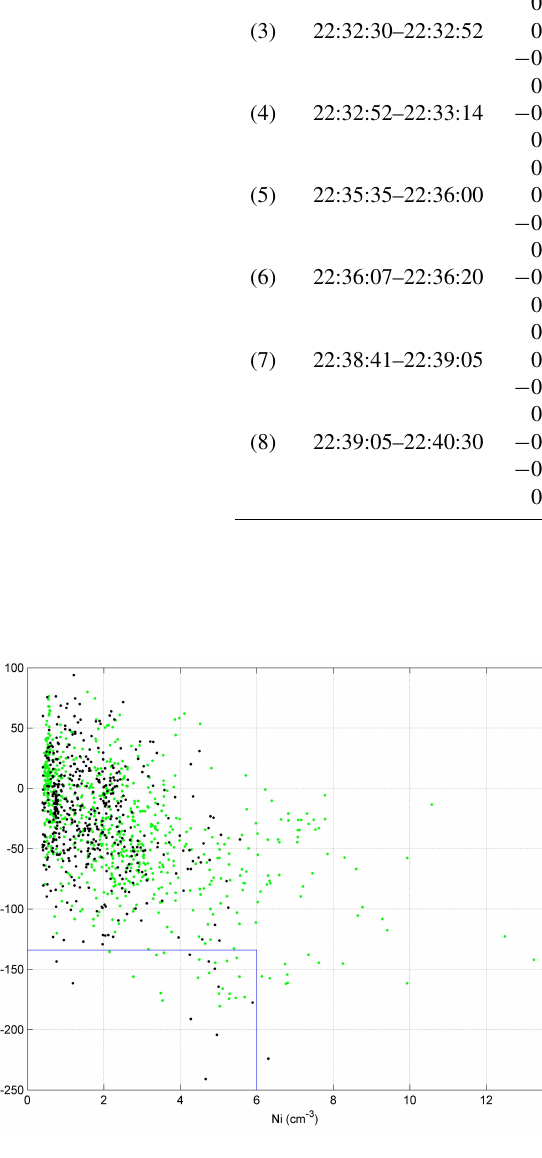
Figure 5. The observed velocity along the tailward direction versus the ion density. Green dots are from TH-A observations and black dots from TH-E observations. The blue lines mark the high-speed and low-density region possibly caused by the acceleration of the